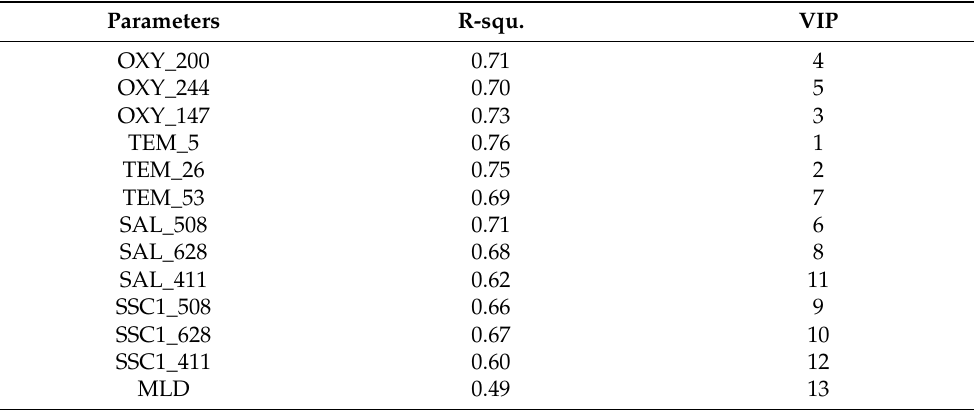
Table 5. Evaluation of different selected environmental layers with respect to